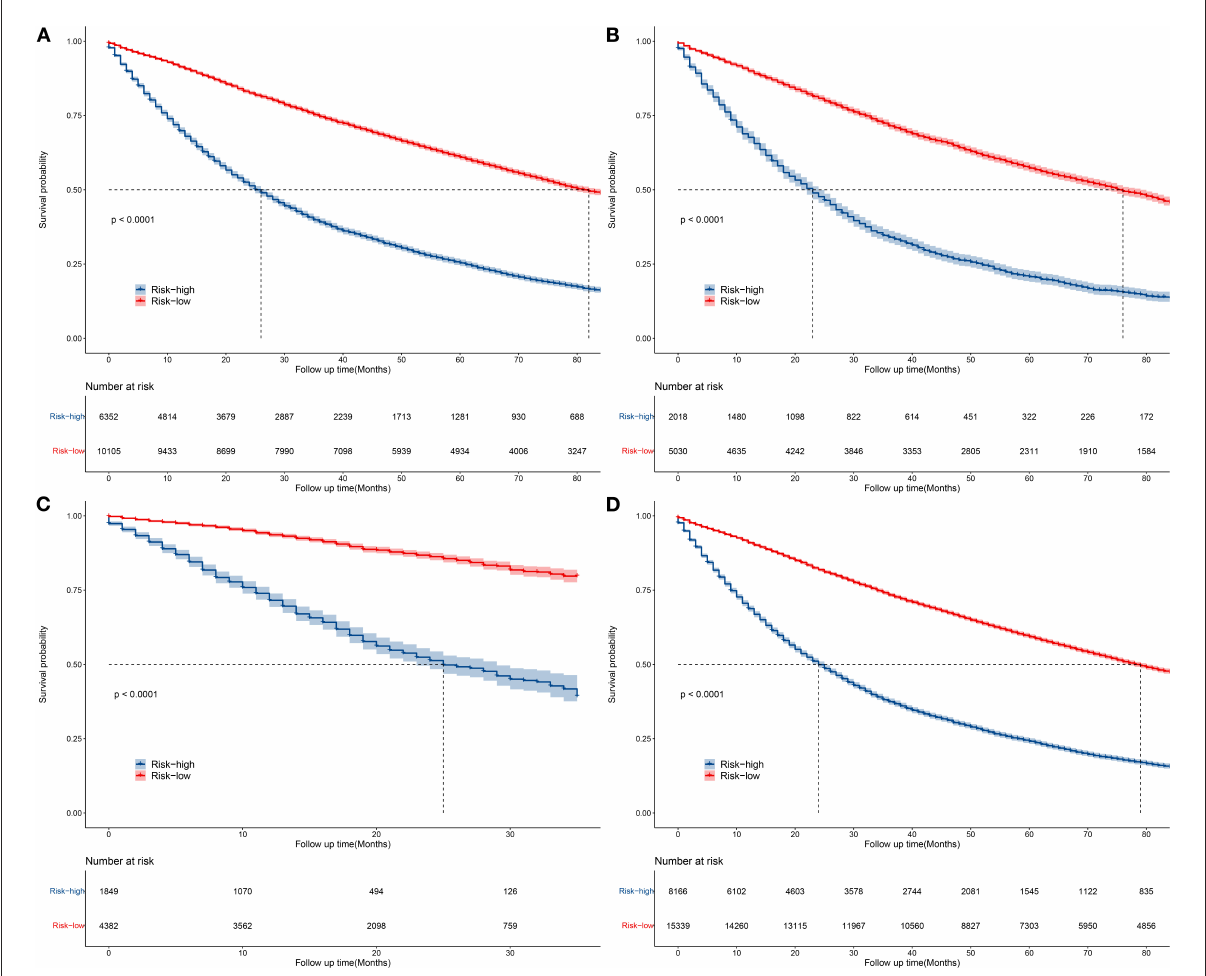
FIGURE6 Kaplan–Meier curves of OS for patients in the low-, and high-risk groups in the training group (A) , validation group (B) , external validation group (C) , and general group (D)